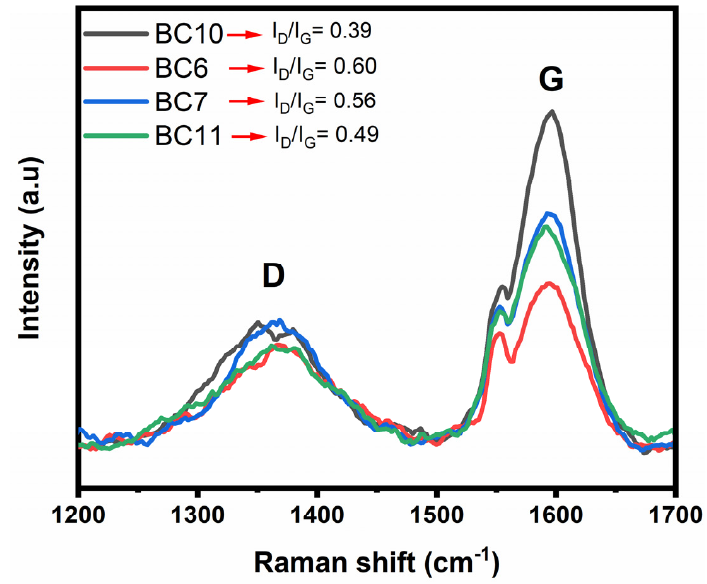
Figure 8. Raman spectra of the BCs .